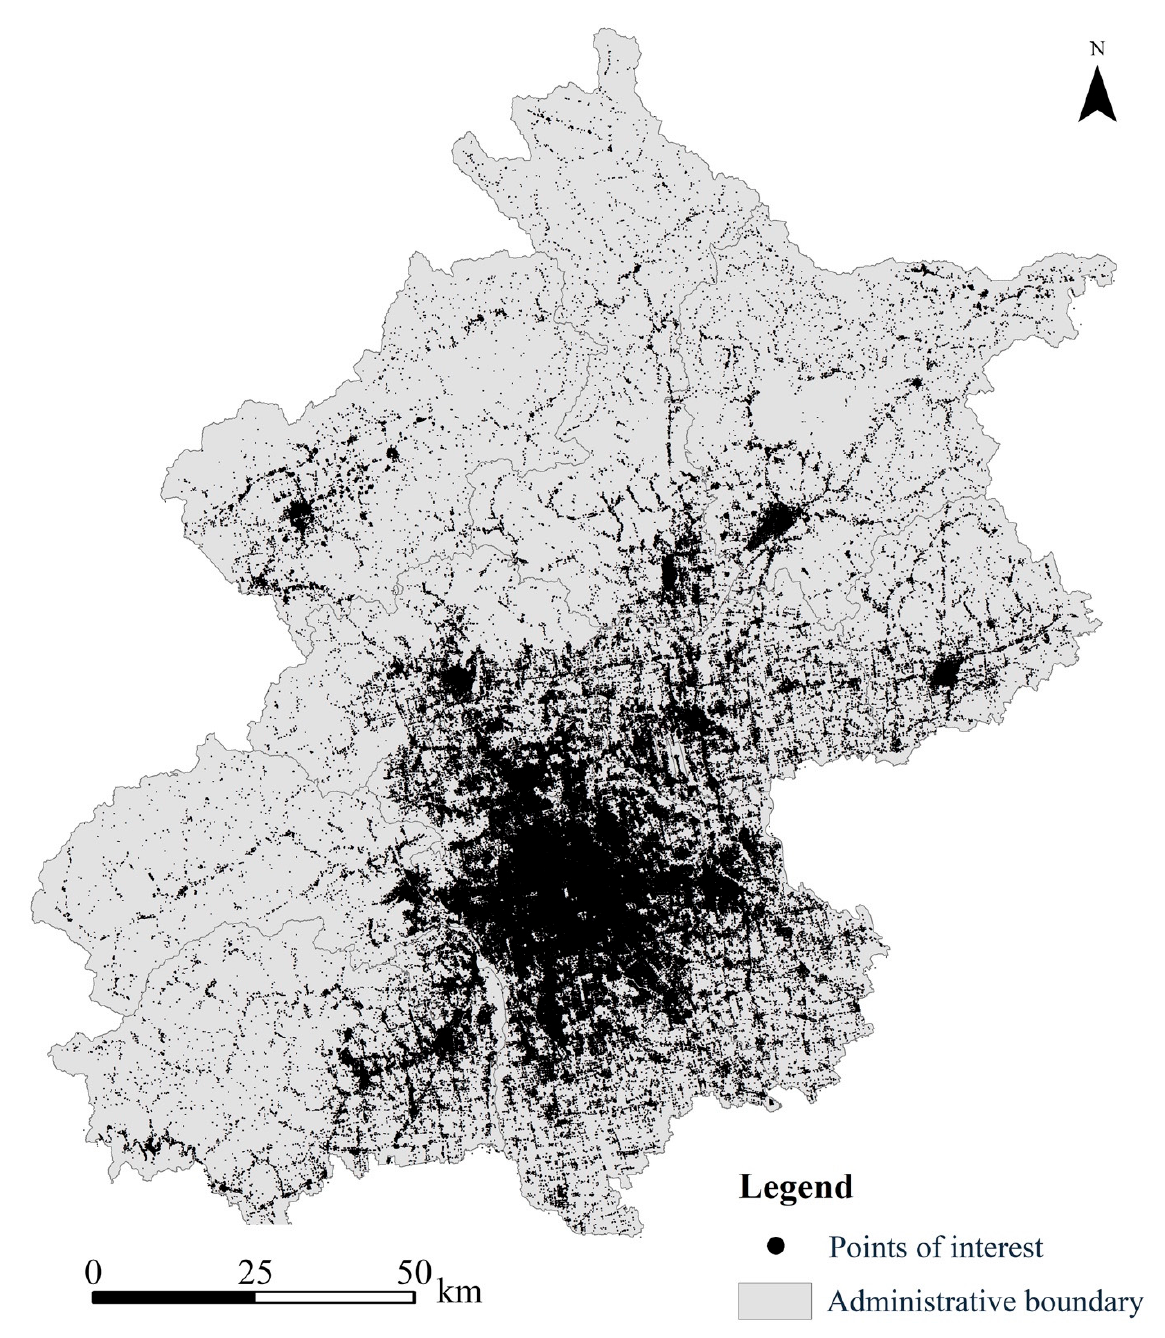
Figure 4. The point of interest (POI) data of Beijing. Table 2. Urban functional zone acquisition and interpretation.